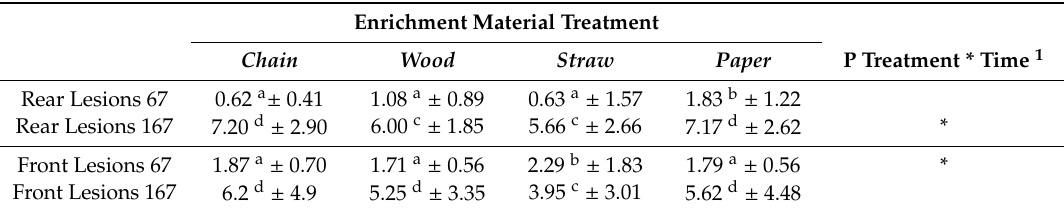
Figure 5. Total number of lesions (counts and standard errors) for the four types of enrichment material over time. * P < 0.05; ** P < 0.01 (see text for specific di ff erences). Table 3. Counts of lesions (mean and standard error) in the rear and front regions before the provision of the enrichment treatments (67 days old) and at the final evaluation (167 days